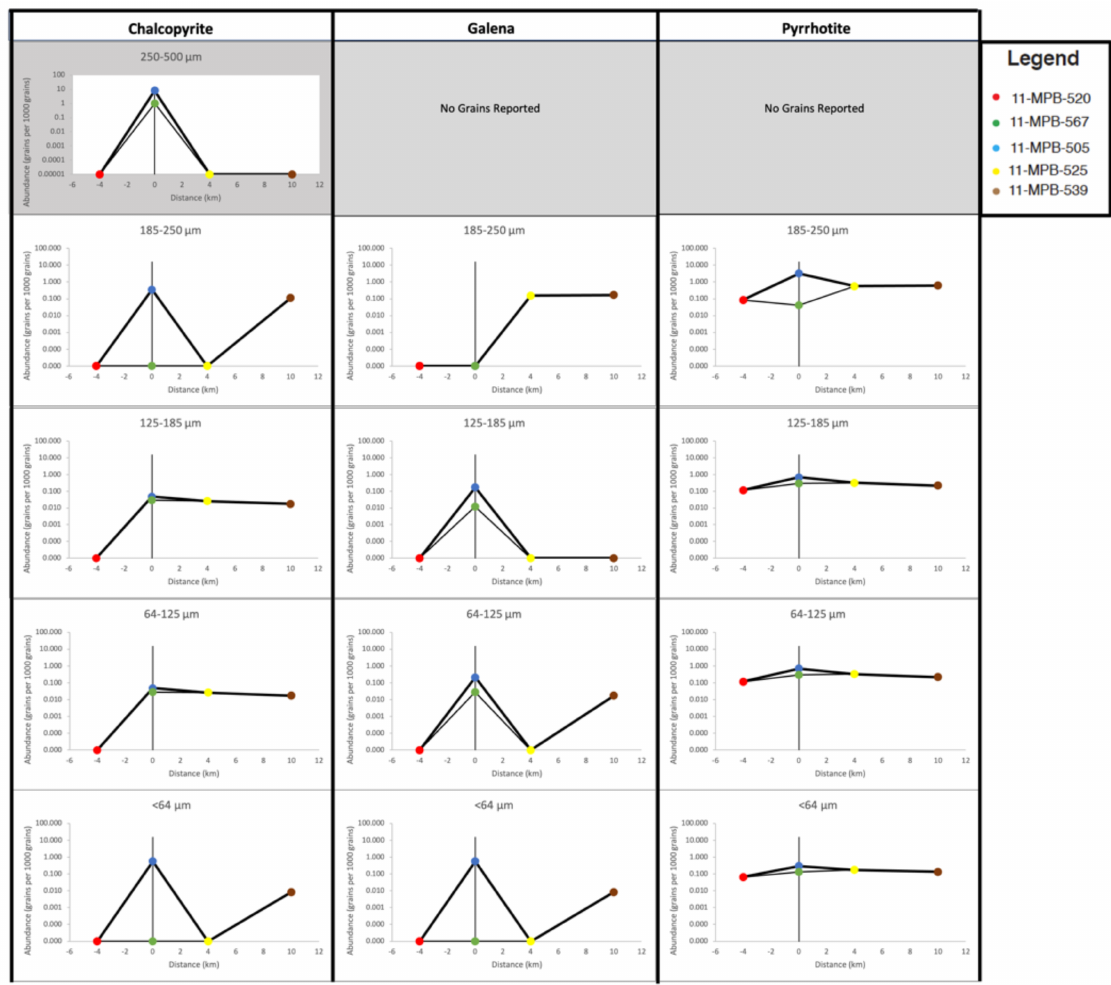
Figure 6. Grain abundance (normalized to grains per 1000 grains) of key sulfide indicator minerals in the 185 to 250, 125 to 185, 64 to 125, and less than 64 µ m heavy-mineral concentrate (HMC) fractions (mineral liberation analysis; this study) of five samples from the Sisson deposit, New Brunswick (log-scaled, y-axis). The x-axis of each is a scaled representation in the direction of ice flow (black arrow). The location of mineralization is denoted by a grey line, and two trendlines depict the inferred decay in indicator mineral abundance along the dispersal train extending from the deposit, taking into account the two separate paths across mineralization (samples 11-MPB-505 and